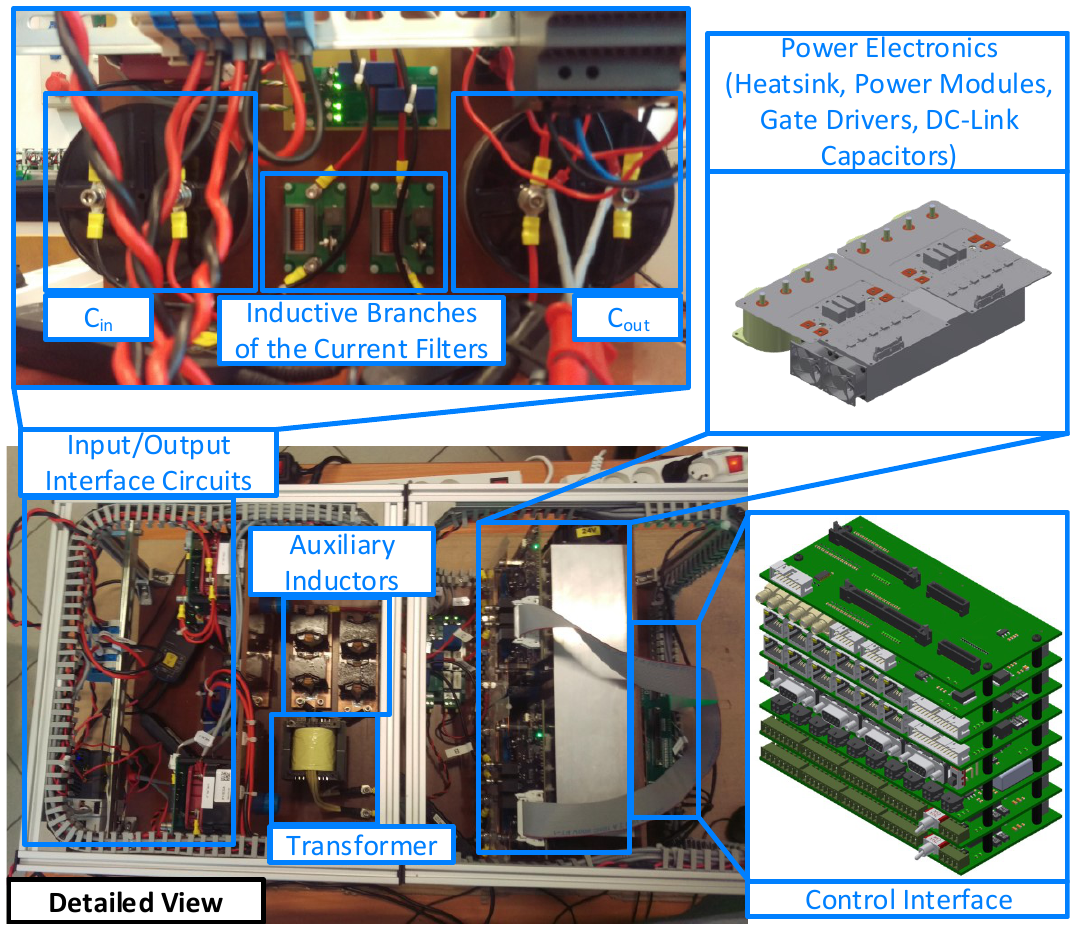
Figure 15. Laboratory prototype of the Dual Active Bridge (DAB) converter with current current